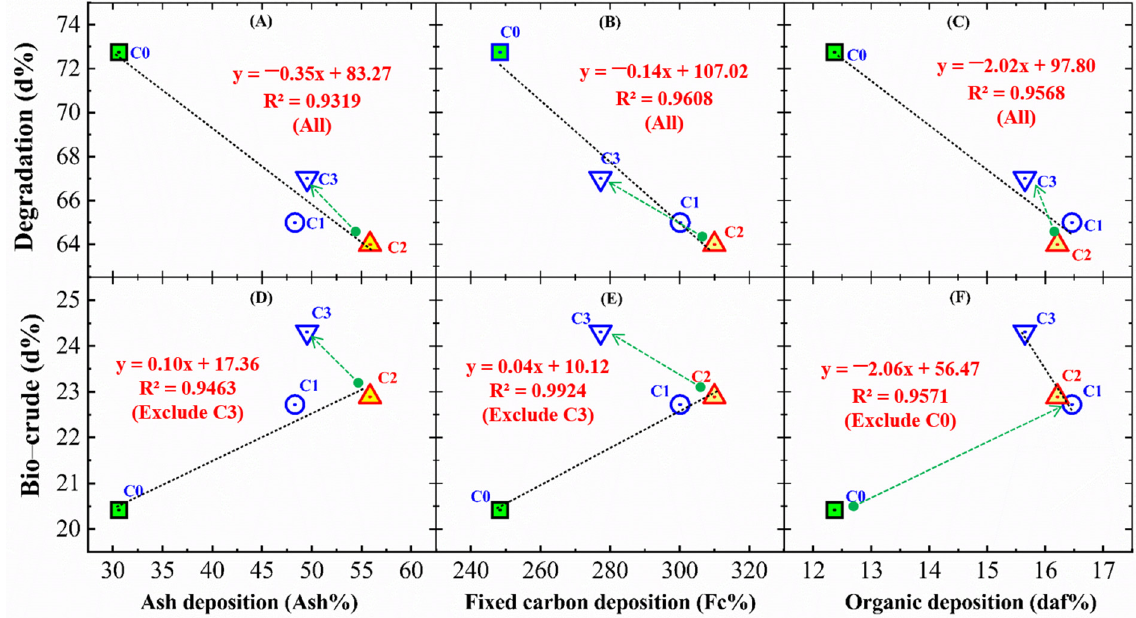
Figure 7. Effect of the deposition characteristics of NDS on hydrothermal degradation ( A – C ) and oil formation ( D – F ).